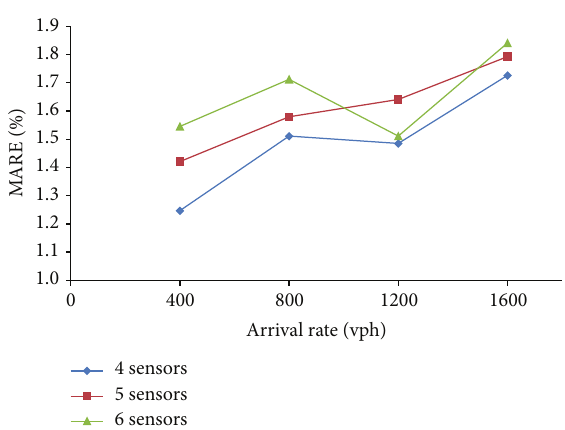
Figure 10: Comparison among MARE in different number of sensors for green wave traffic